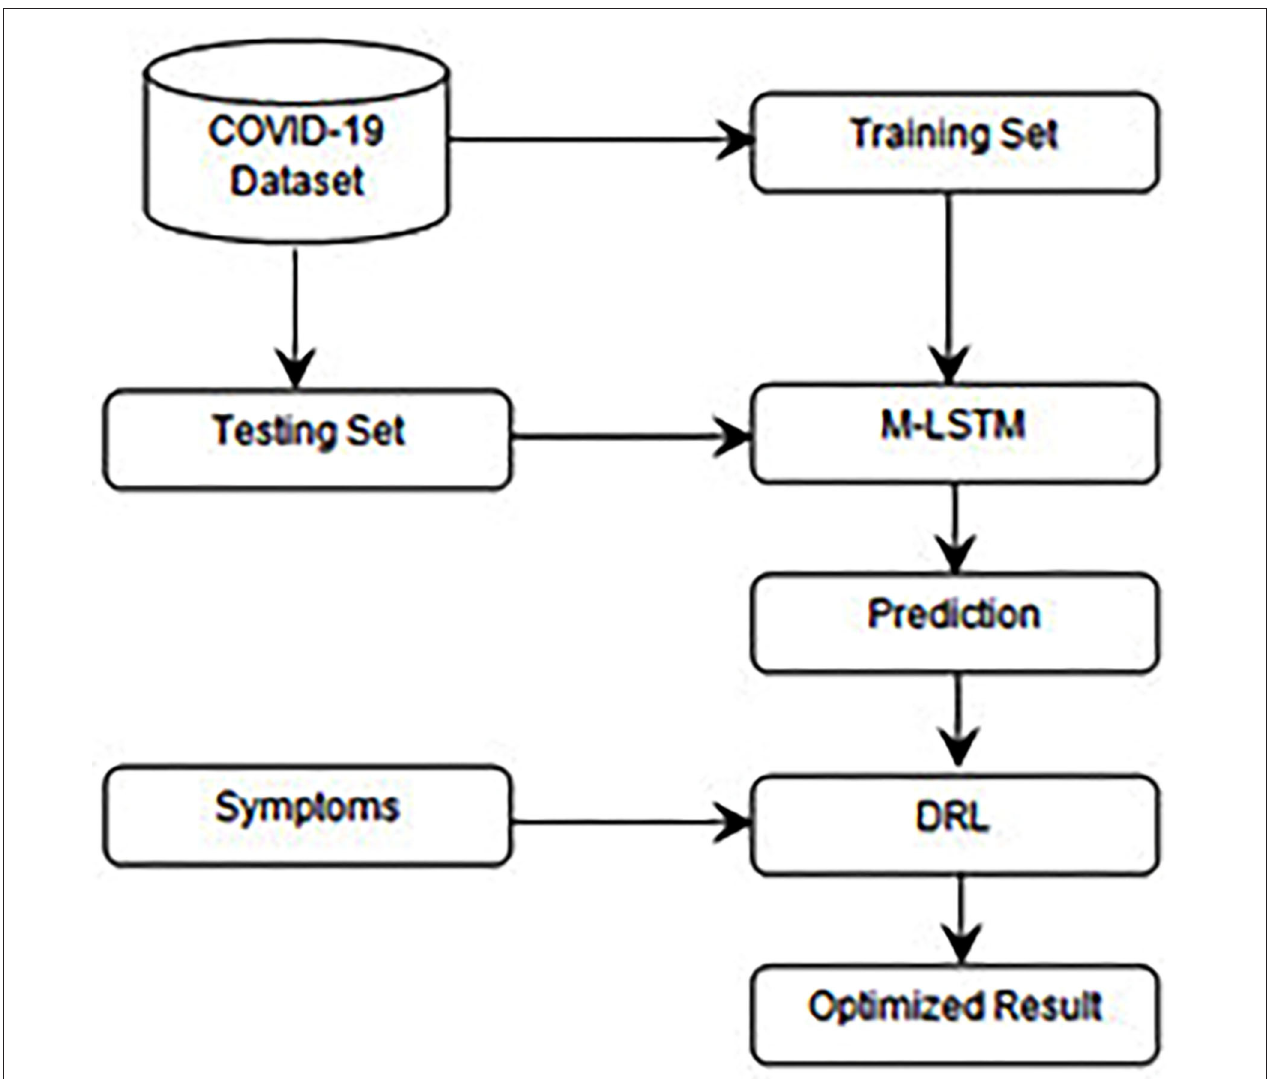
FIGURE 3 | Workflow of the proposed